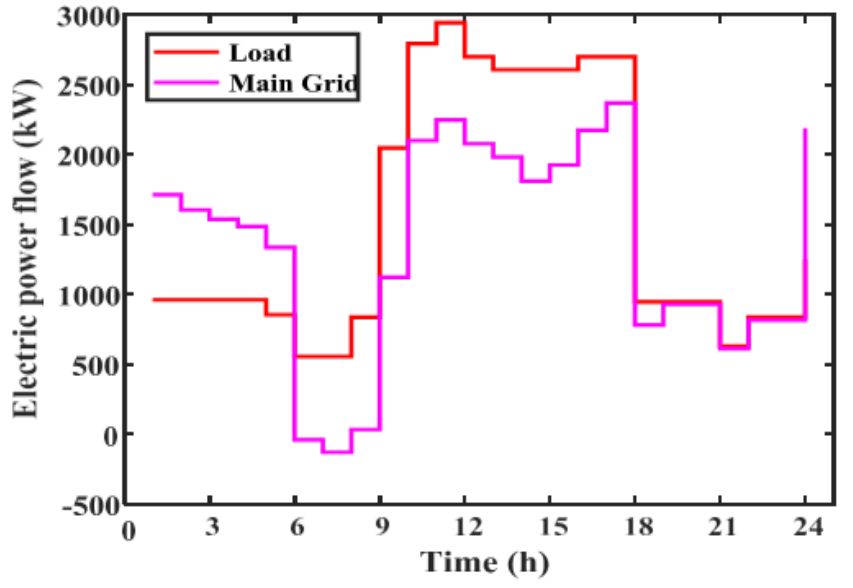
Figure 9. Electrical dispatch with DER, DR & storage.